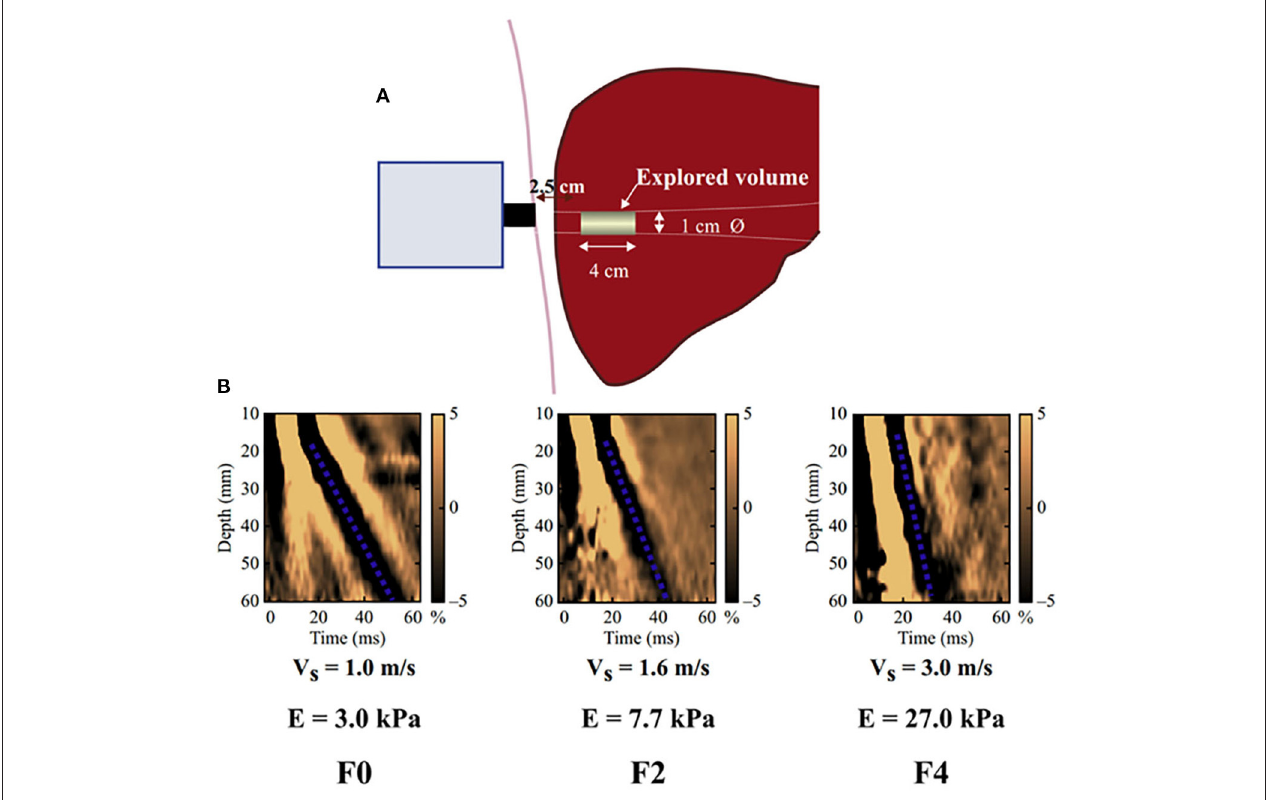
FIGURE 1 | Schematic diagram of the basic principles of hepatic transient elastography. (A) Schematic diagram of basic principles of transient elastic imaging of liver. (B) Judging the severity of liver fibrosis according to shear wave propagation velocity. The elastic modulus E is expressed as E = 3 ρ V2, where V is the shear velocity and ρ is the mass density (constant and close to 1 kg/m 3 for the tissue): the harder the tissue, the faster the shear wave propagates. In the absence of fibrosis (F0), the speed was 1.0 m/s and the elasticity was 3 kPa, while in the case of cirrhosis (F4), the speed was 3.0 m/s and the elasticity was 27